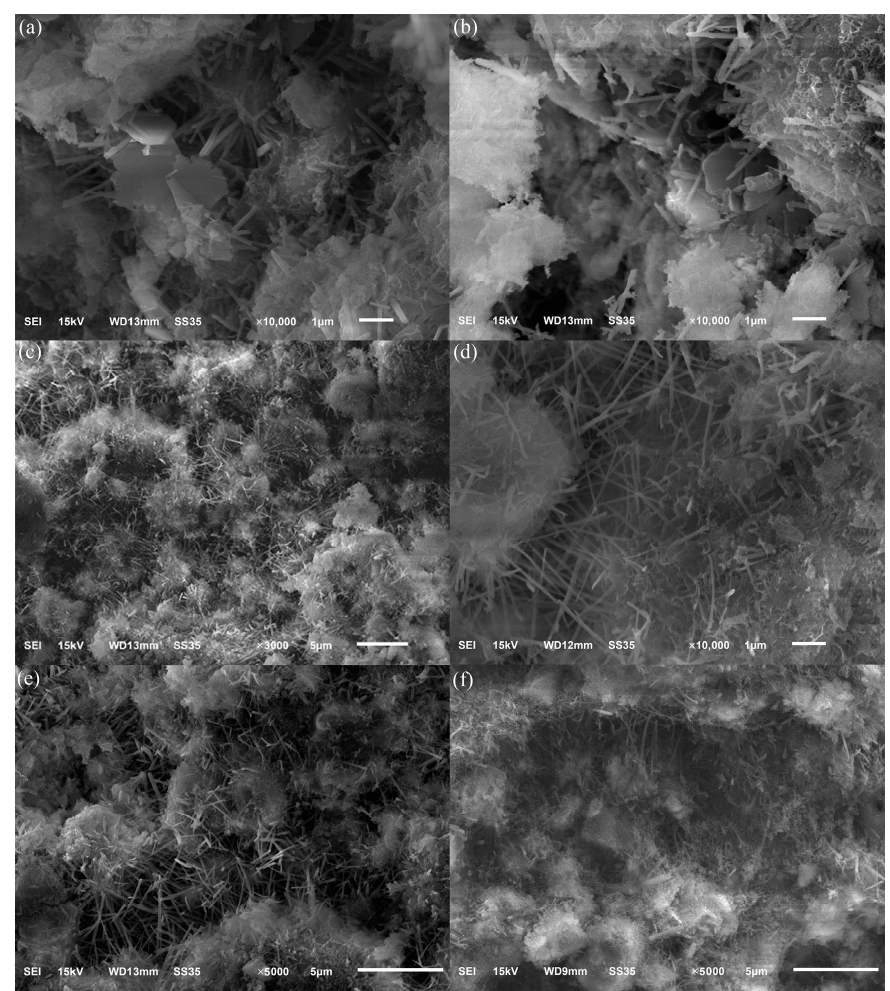
Figure 9. SEM images of hydration pastes cured for 3 days ( a , b ), 28 days ( c , d ), and 90 days ( e , f